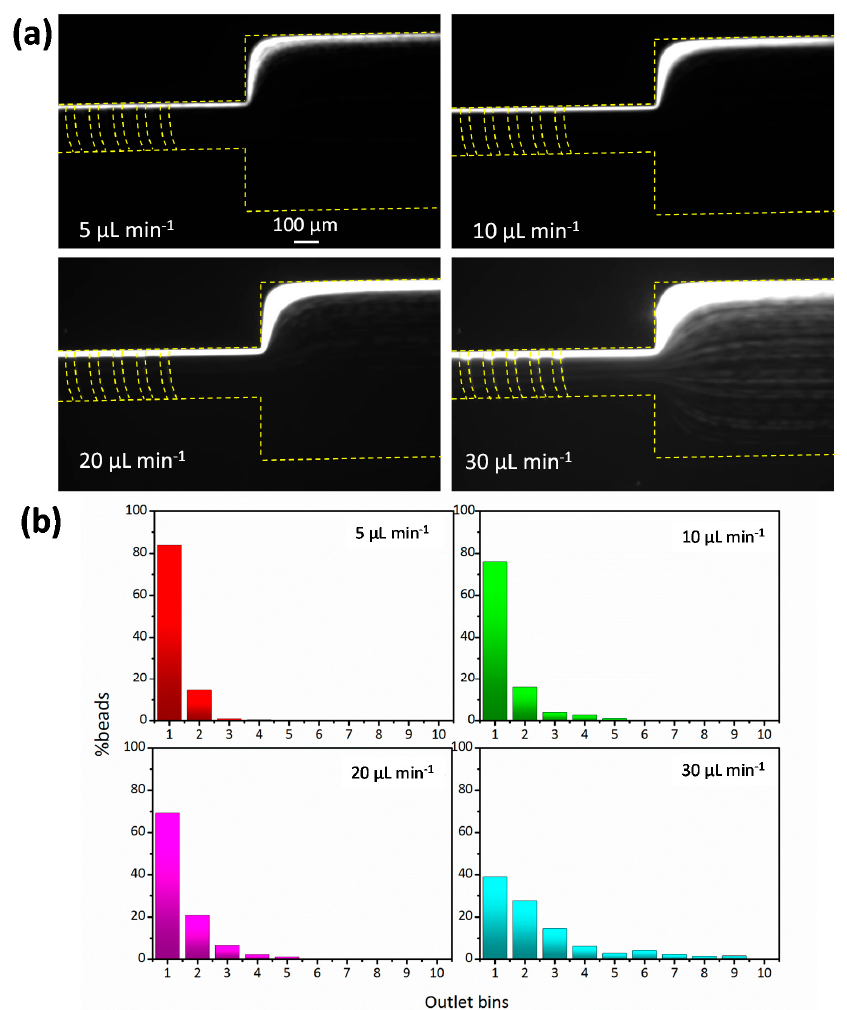
Figure 3. ( a ) Optical micrographs showing particle trajectories at the channel outlet at flow rates of 5, 10, 20, and 30 µL·min − 1 . Particles with a diameter of 13 µm were spiked into the undiluted blood; ( b ) a plot of particle distribution at the channel outlet for varying flow rates. More than 500 beads were counted for each experiment.